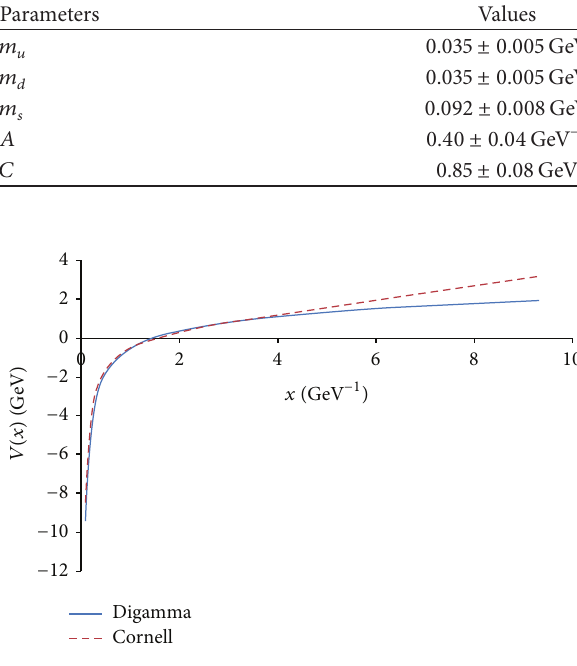
Figure 1: The digamma-type and Cornell potentials versus the hyperradius 𝑥